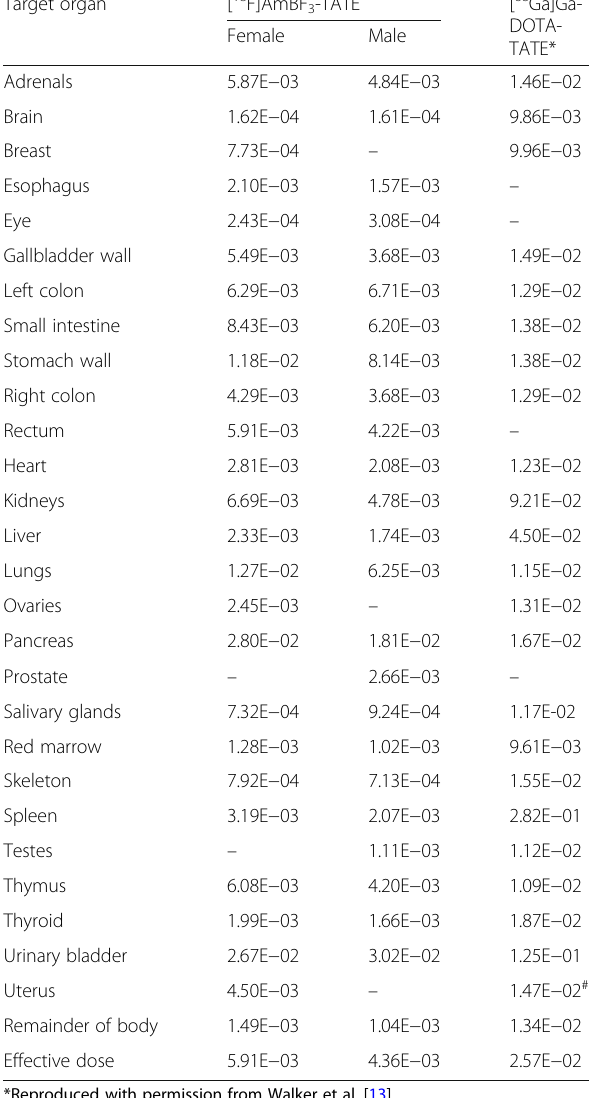
Table 1 Estimated absorbed doses [mSv/MBq] for different organs in the average adult calculated with OLINDA software